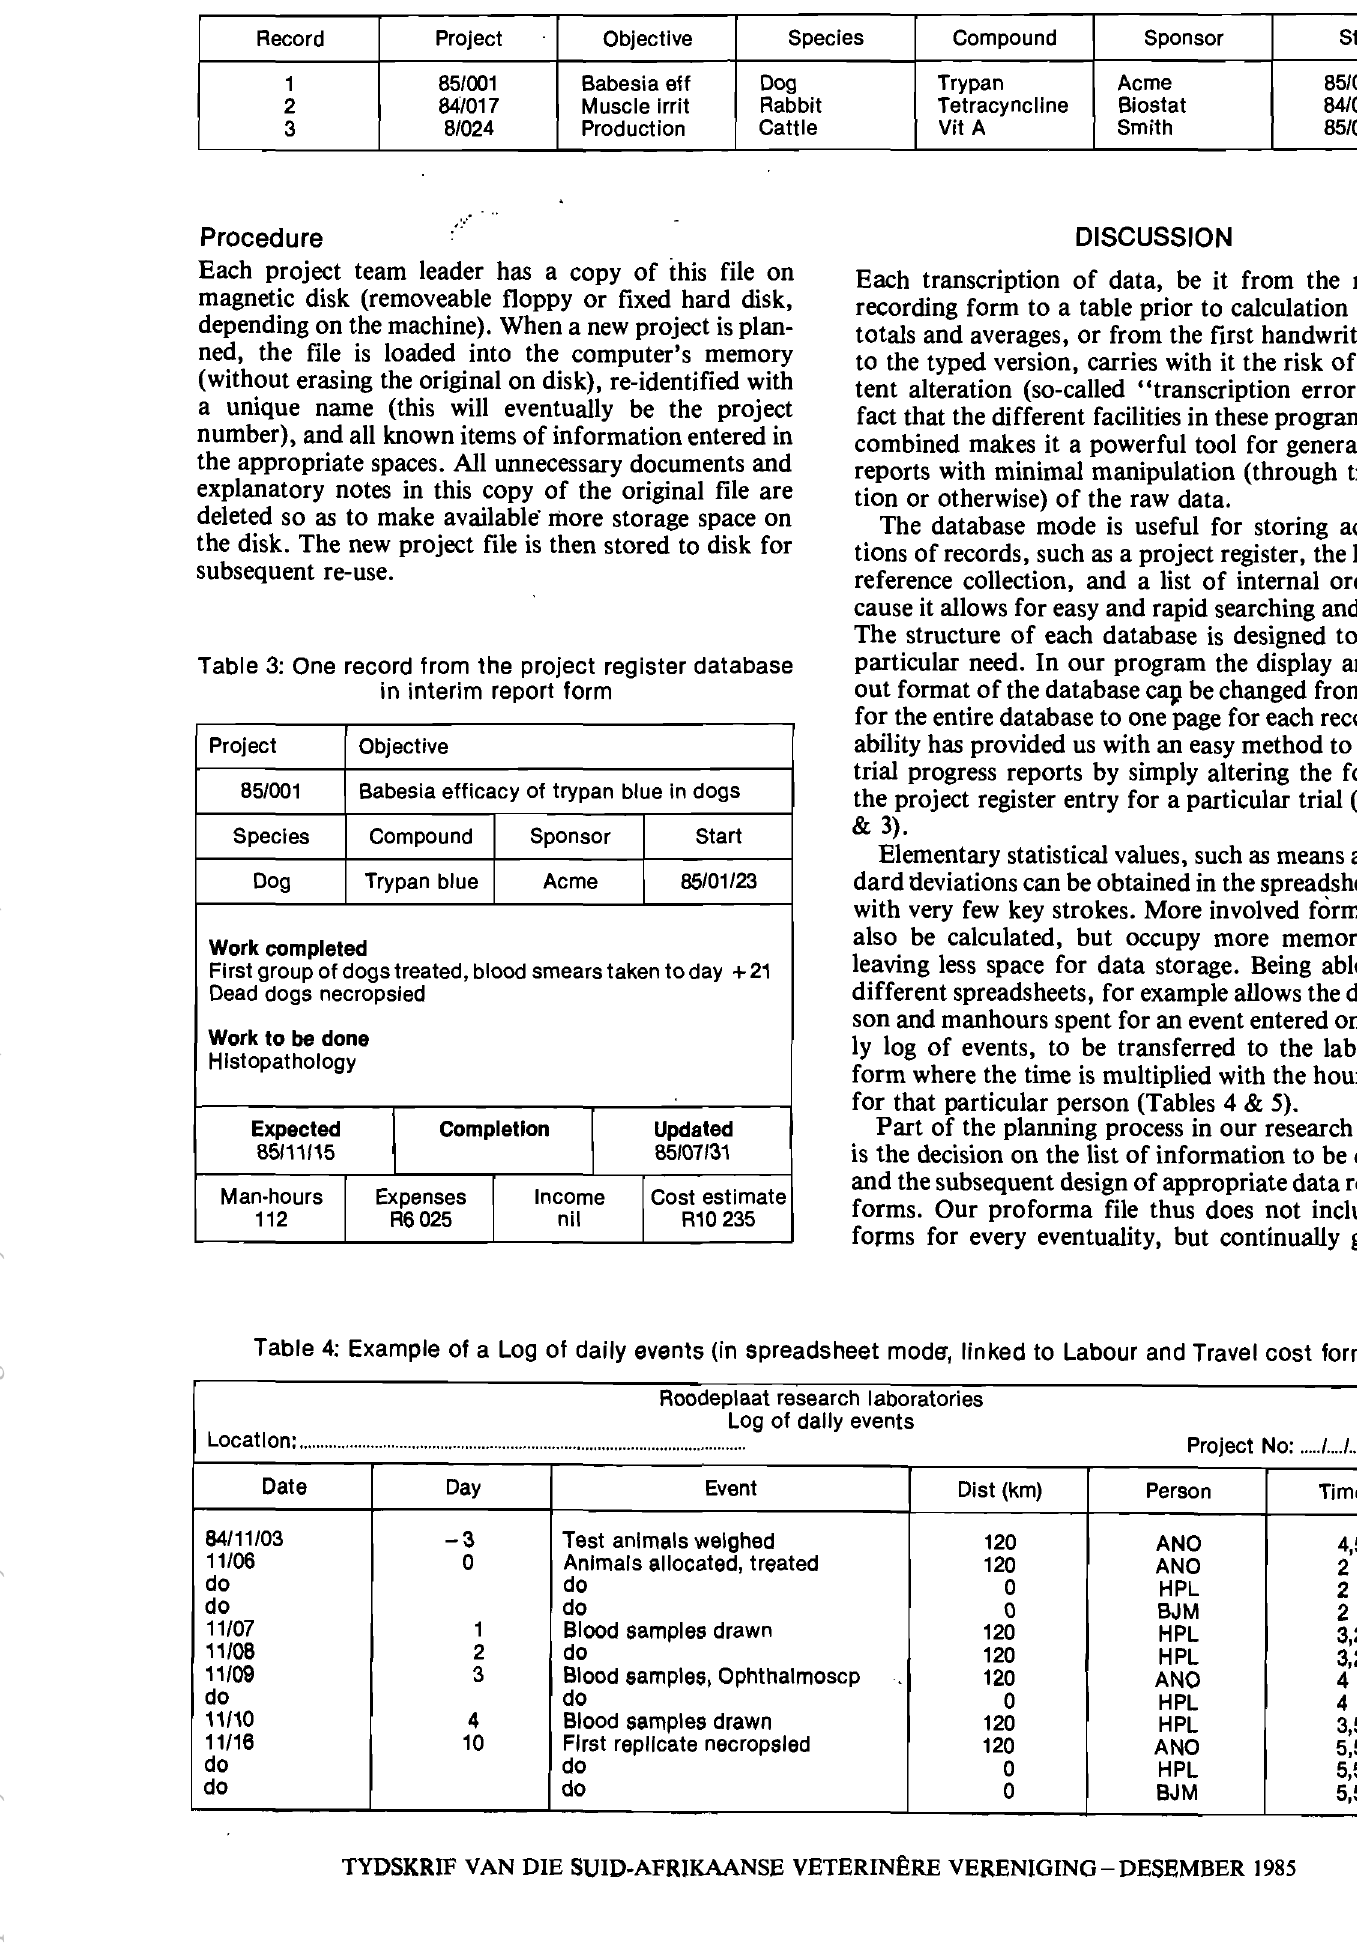
Table 4: Example of a Log of daily events (in spreadsheet modEJ, linked to Labour and Travel cost forms) Roodeplaat research laboratories Log of dally